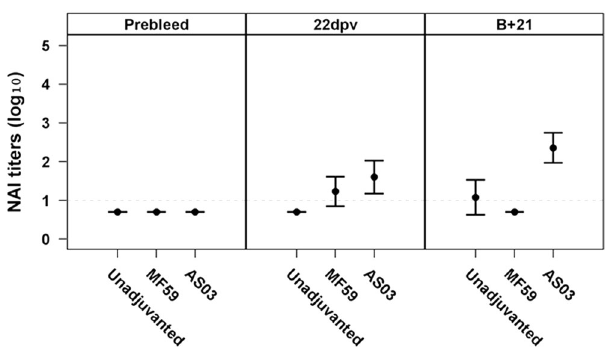
Fig. 5 Cross-reactive antibodies against the N1 of the H5 strain elicited by TIV vaccination. Sera from the TIV vaccinated ferrets were tested for cross-reactive antibodies against N1 from the H5 virus. Antibody titers are expressed as mean log 10 -antibody titer, with the error bars representing the standard deviation. Dashed line (at Y = 1) indicates the limit of assay detection. Statistically signi fi cant differences were tested by ANOVA of log-transformed antibody titers for all antigens and vaccine groups and post hoc tests with Bonferroni adjustments for multiple comparisons. Asterisk denotes p -value < 0.05, ** p < 0.01, *** p < 0.001